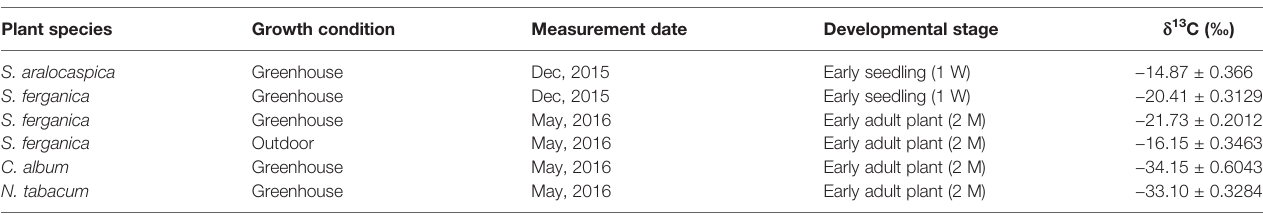
TABLE 4 | d 13 C value of S. ferganica and other plant